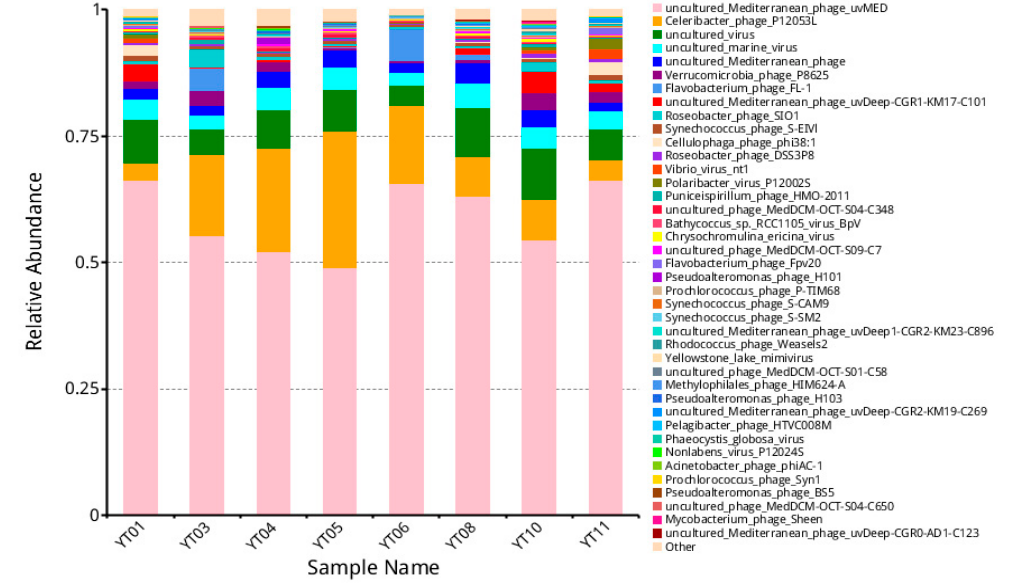
Figure 3. Relative abundance of the 41 most common viral species in G. catenatum bloom samples.